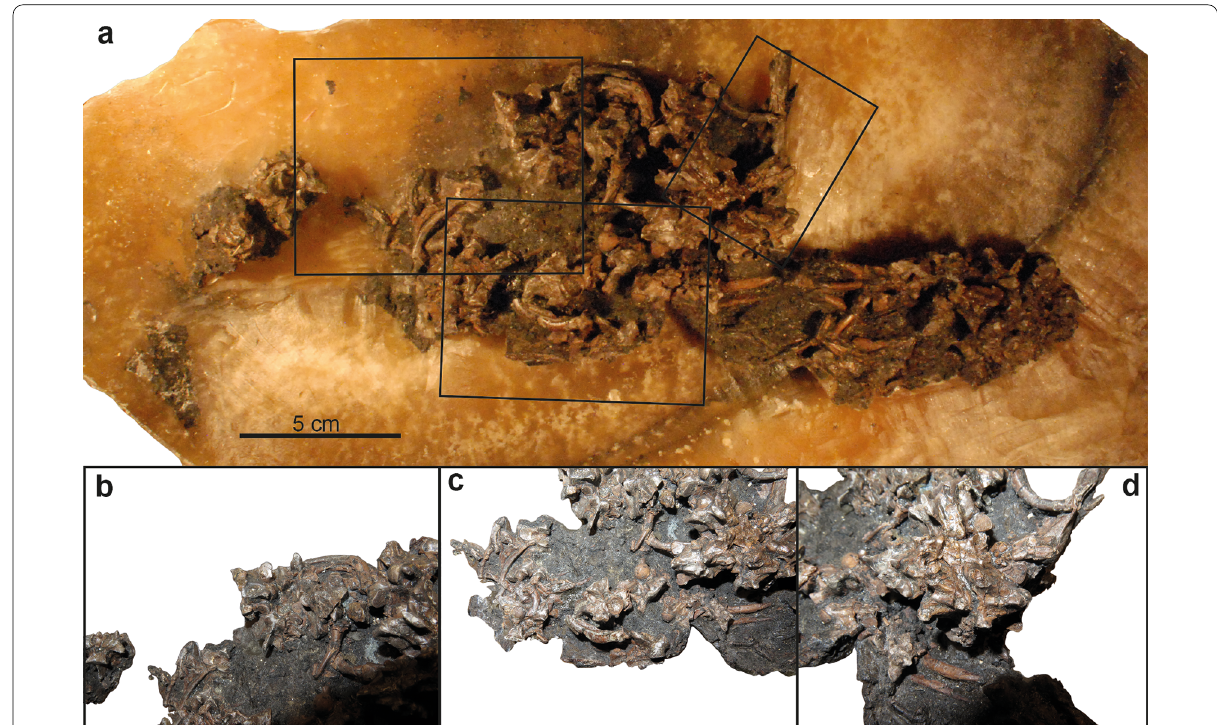
Fig. 25 Palaeopython ceciliensis from quarry Cecilie IV, Geiseltal: a several articulated and disarticulated trunk vertebrae and ribs on a matrix (GMH Ce IV-5854-1933); b – d close ups of the same